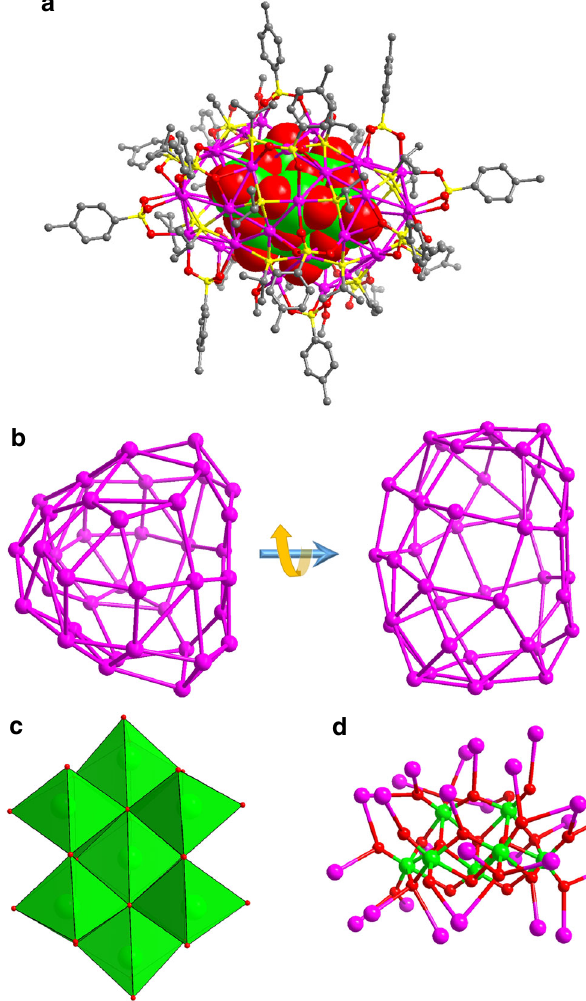
Fig. 4 Single-crystal structure of SD/Ag11 . a The total structure of SD/Ag11 with Mo 7 O 24 6 − shown in space fi lling mode. b The Ag 41 skeleton viewed along different directions. c Polyhedral representation of Mo 7 O 24 6 − . d The bonding between Mo 7 O 24 6 − and Ag atoms at the shell. (Colour legend: purple, Ag; yellow, S; red, O; green,